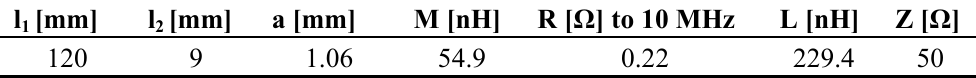
Table 2. Parameters of the used